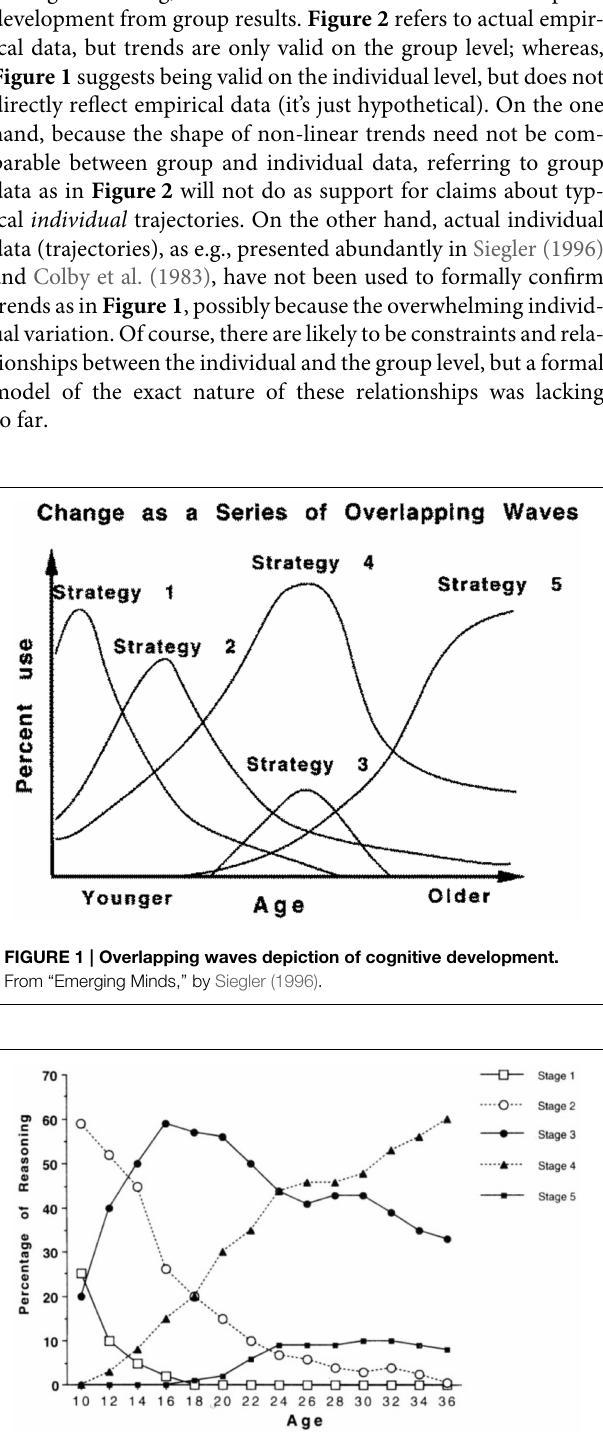
FIGURE 2 | Percentage use of stages of moral reasoning. Data from Colby et al.